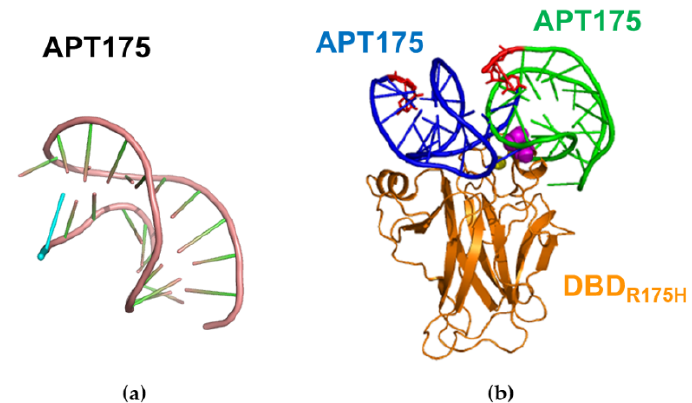
Figure 11. ( a ) Graphical representation of the best model for the APT175 aptamer. ( b ) Graphical representation of the two predicted best arrangements for the APT175 with respect to DBD R175H in the complex. The 3 (cid:48) end of APT175 is marked in red. The figures were created by Pymol